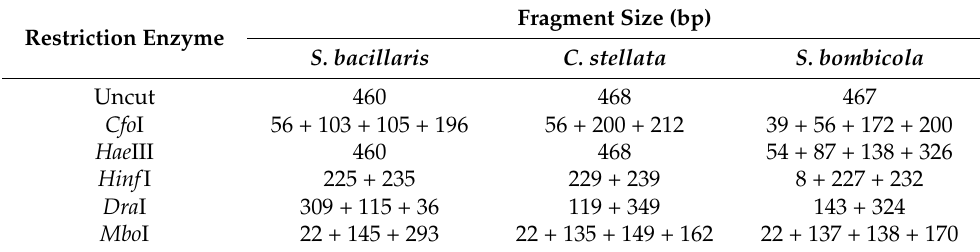
Table 1. Digestion pattern of S. bacillaris ITS-5.8S region.